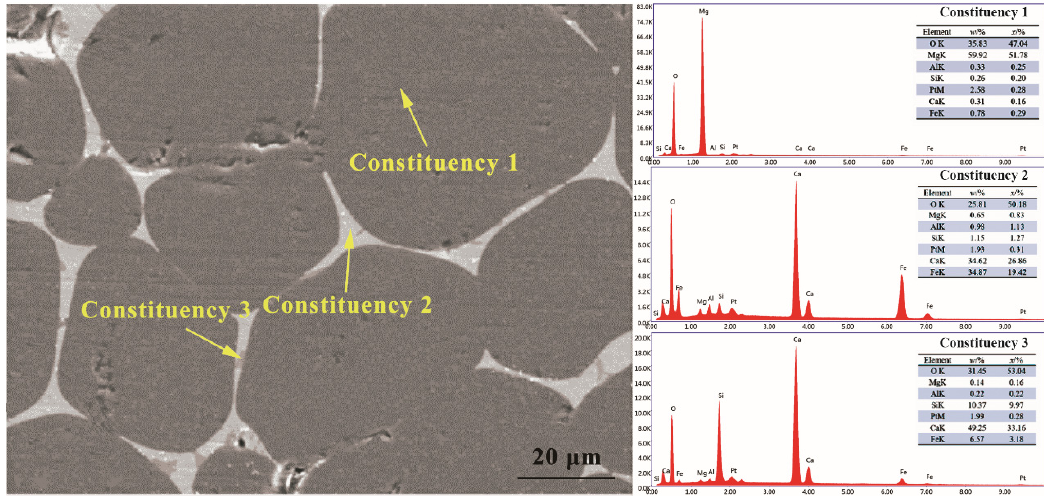
Figure 4. Microstructure and energy spectrum analysis of the MgO ‐ CaO ‐ Fe 2 O 3 clinker.